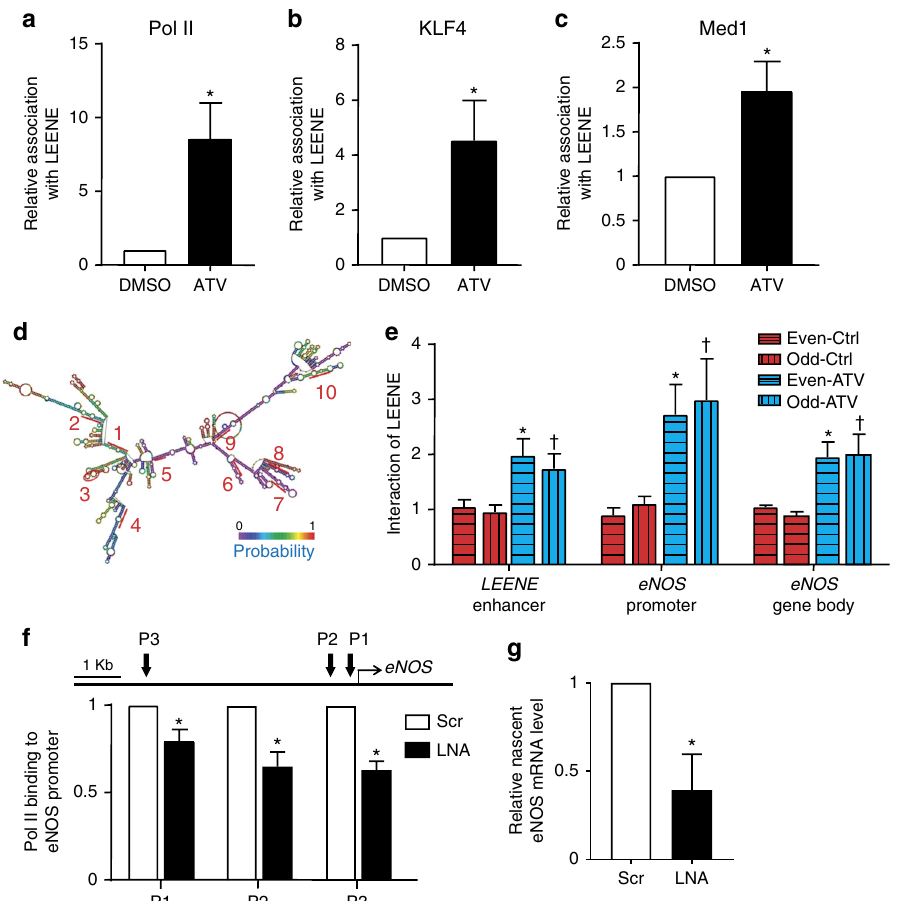
Fig. 6 LEENE RNA promotes RNA Pol II binding and eNOS transcription. a – c , e HUVECs were treated with ATV for 24 h. The binding of RNA Pol II, KLF4, and MED1 to LEENE RNA was determined by RIP followed by qPCR ( a – c ). d Predicted secondary structure of LEENE RNA based on minimum free energy (MFE) and fragments complementary to ChIRP probes are labeled with numbers 1 – 10. Color scale shows the probabilities for every nucleotide to hold the structural position. Following ChIRP, interactions between LEENE RNA and respective DNA regions of LEENE and eNOS were detected by qPCR (in e ). f , g Static ECs were transfected with scramble or LEENE LNA. The binding of RNA Pol II to eNOS promoter was determined by ChIP-qPCR with three primer sets fl anking three regions upstream of eNOS TSS (in f ). g Nascent RNA was captured in static ECs transfected with scramble or LEENE LNA. eNOS mRNA level was detected by qPCR. Data are presented as mean ± SEM, n = 5 in each group. * p < 0.05 compared with respective control in each experiment. In a – c , * denotes p < 0.05 compared with DMSO; in e , * indicates p < 0.05 between Ctrl and ATV using even-numbered probes; † denotes p < 0.05 between Ctrl and ATV using odd-numbered probes; in f and g , * means p < 0.05 between scramble vs. LNA groups. Student ’ s t test was